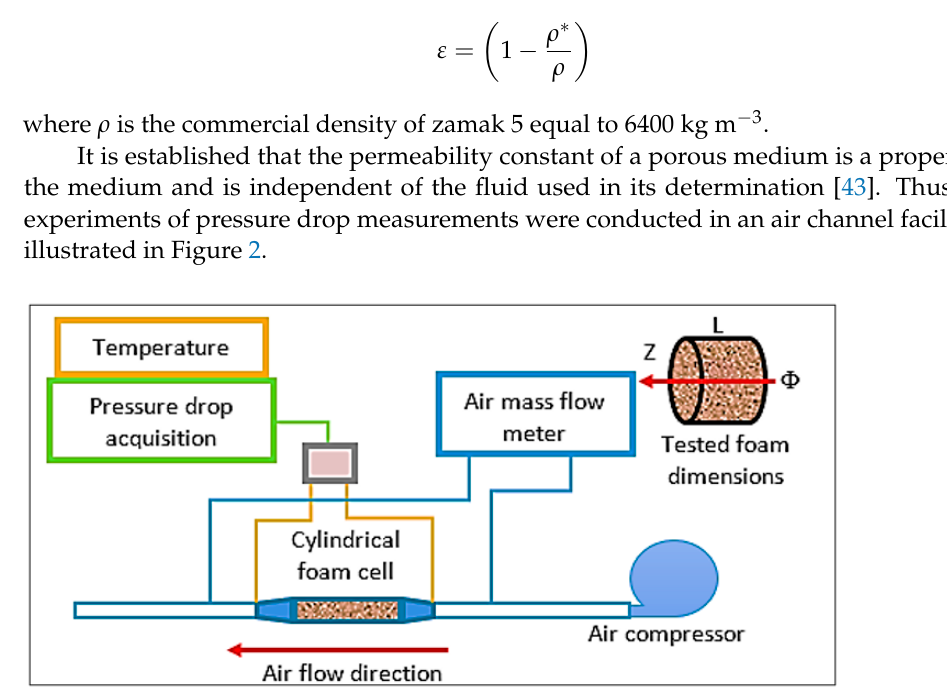
Figure 2. Experimental setup of the air channel used for permeability measurements of the different zamak 5 foams.